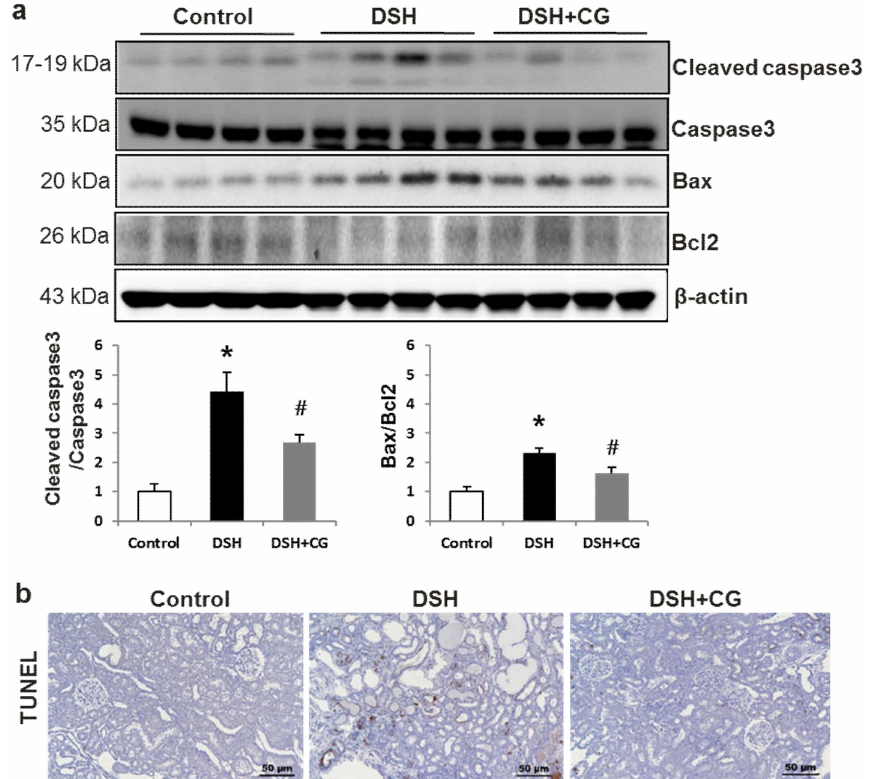
Figure 7. CG200745 deceases apoptosis in the kidneys of deoxycorticosterone acetate (DOCA)-salt hypertensive (DSH) rats. ( a ) The expression of cleaved caspase3 was increased, which was attenuated by CG200745 treatment (DSH + CG). The Bax/Bcl2 ratio was also markedly increased in DSH rats, which was attenuated by CG200745 treatment. The expression of Bax was increased, whereas Bcl2 was decreased in the DSH groups compared to those in controls. The Bax/Bcl2 ratio was markedly increased in DSH rats, which was attenuated by CG200745 treatment; * p < 0.05, when DHS or DSH + CG groups were compared to control group. # p < 0.05, when DSH + CG group was compared to DSH